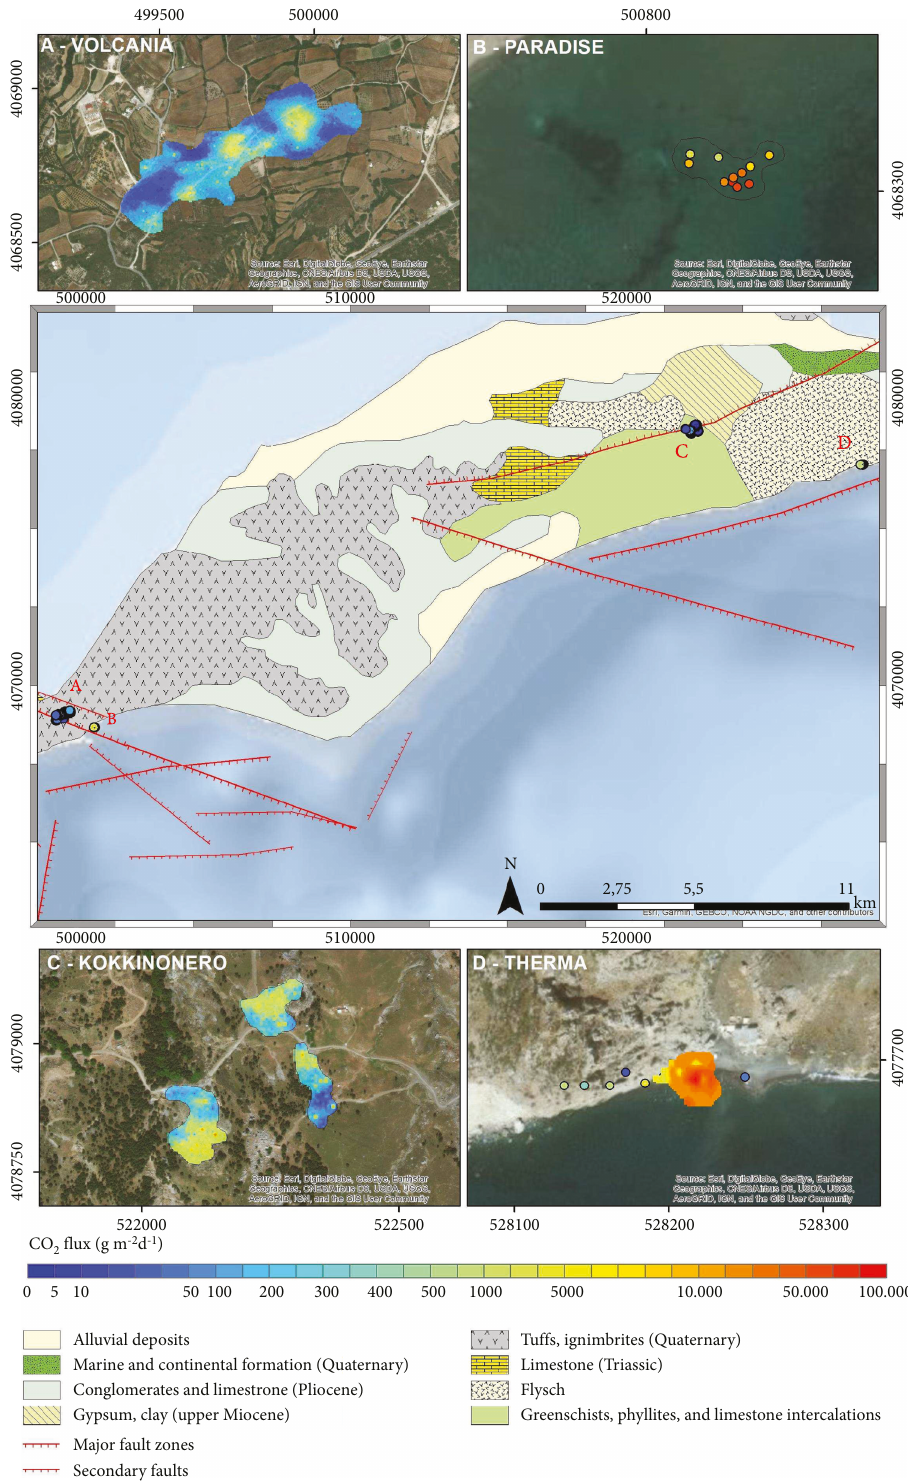
fl ux measurements at Kos. (c) The map of the central part of the island showing all measured points. Figure 9: Distribution maps of soil CO 2 (a, b, d, and e) Areas with more detailed sample density: Volcania (a), Paradise beach (b), Therma (d), and Kokkino Nero